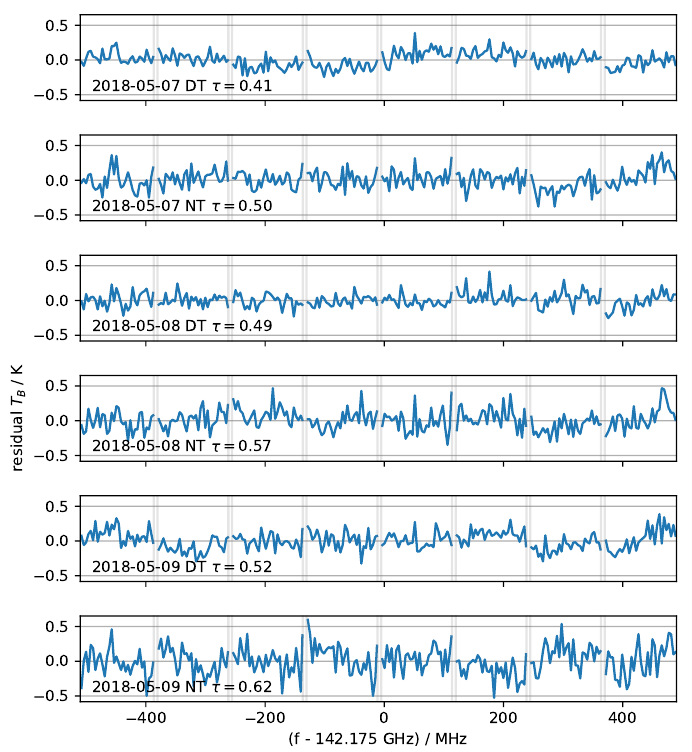
Figure 6. Residuals from six measurements taken during three days, daytime (DT) and nighttime (NT) obtained from the retrieval of ChB only. Residuals are binned (64 FFTS channels) for each part